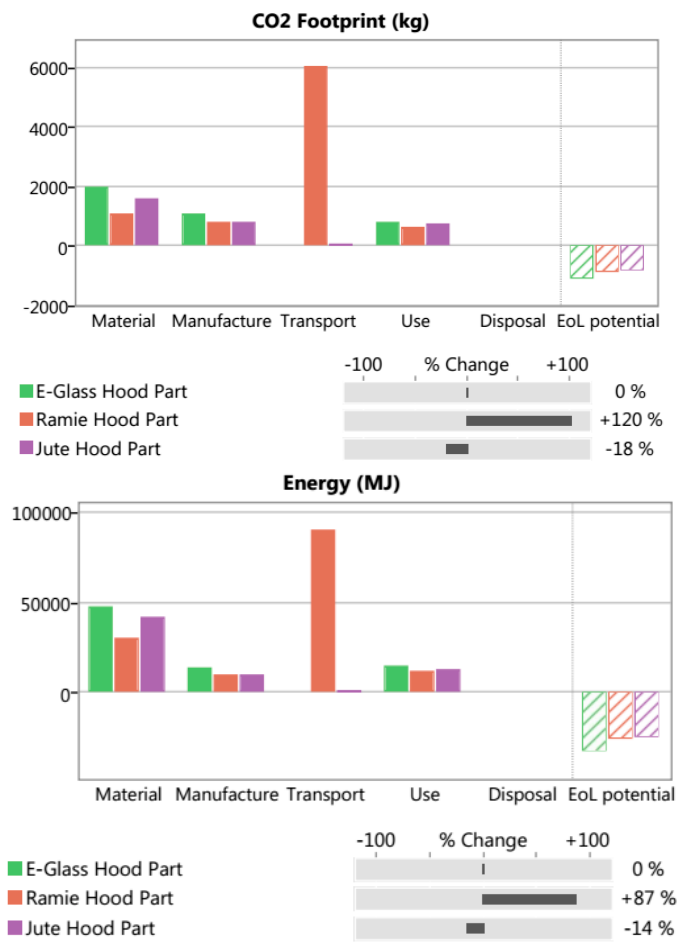
Figure 9. Glass fiber hood against ramie and jute eco-audit summary charts.